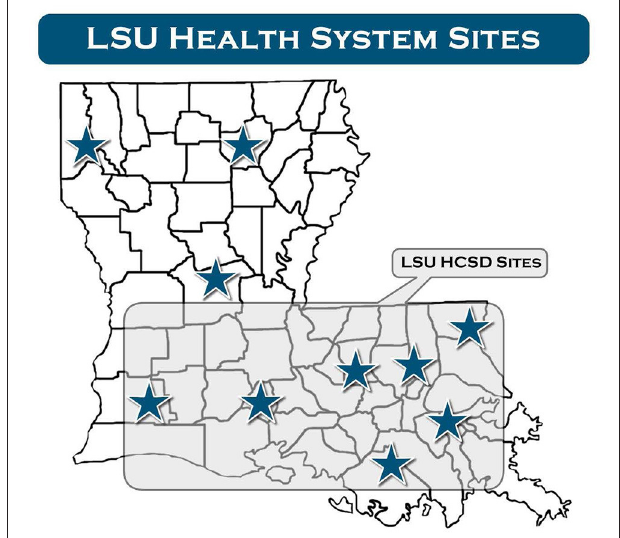
FIGURE 1 | Louisiana Public Hospital system.